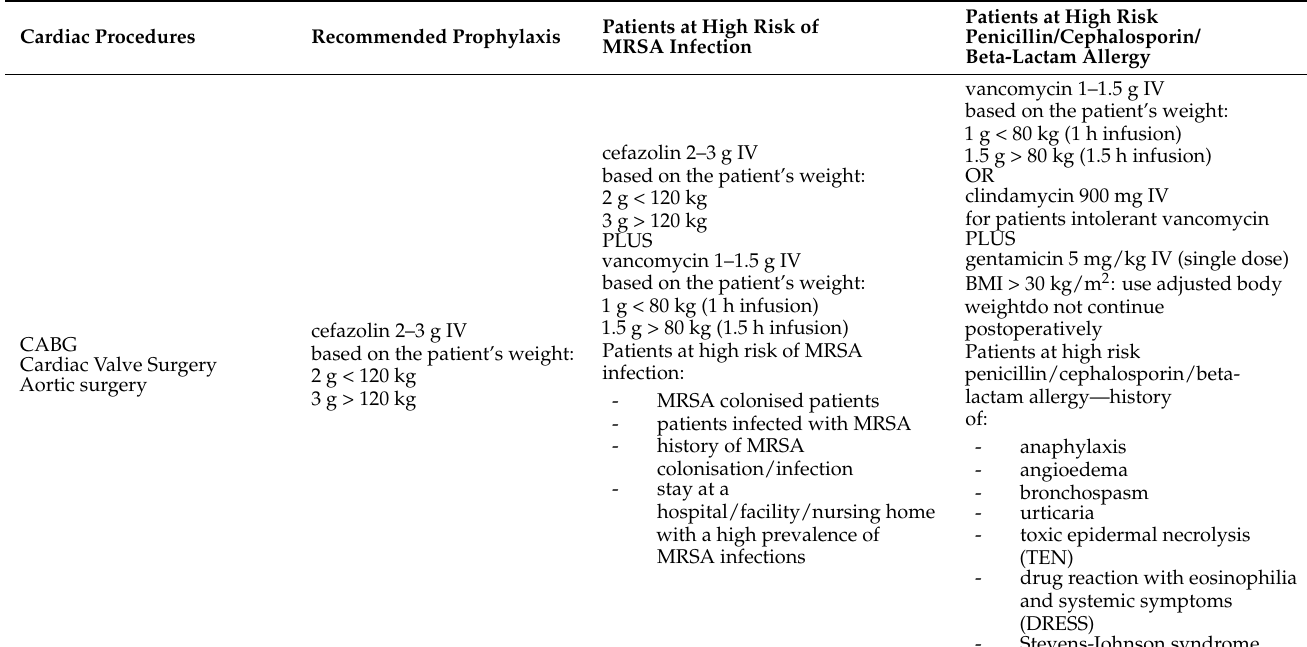
Table 2. Perioperative antibiotic prophylaxis (PAP) in cardiac surgery. Cardiac